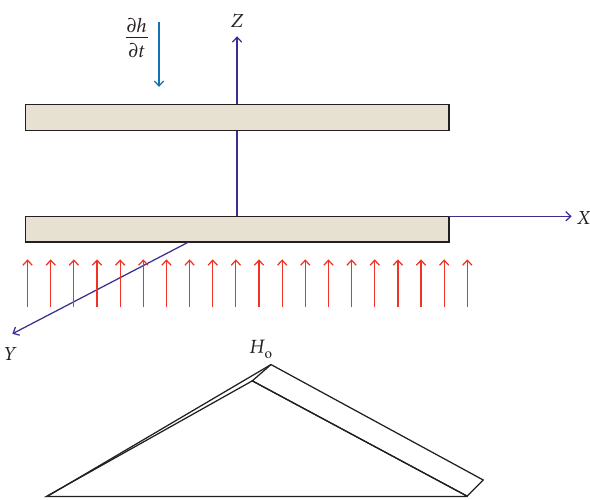
Figure 1: Squeeze film geometry between parallel triangular